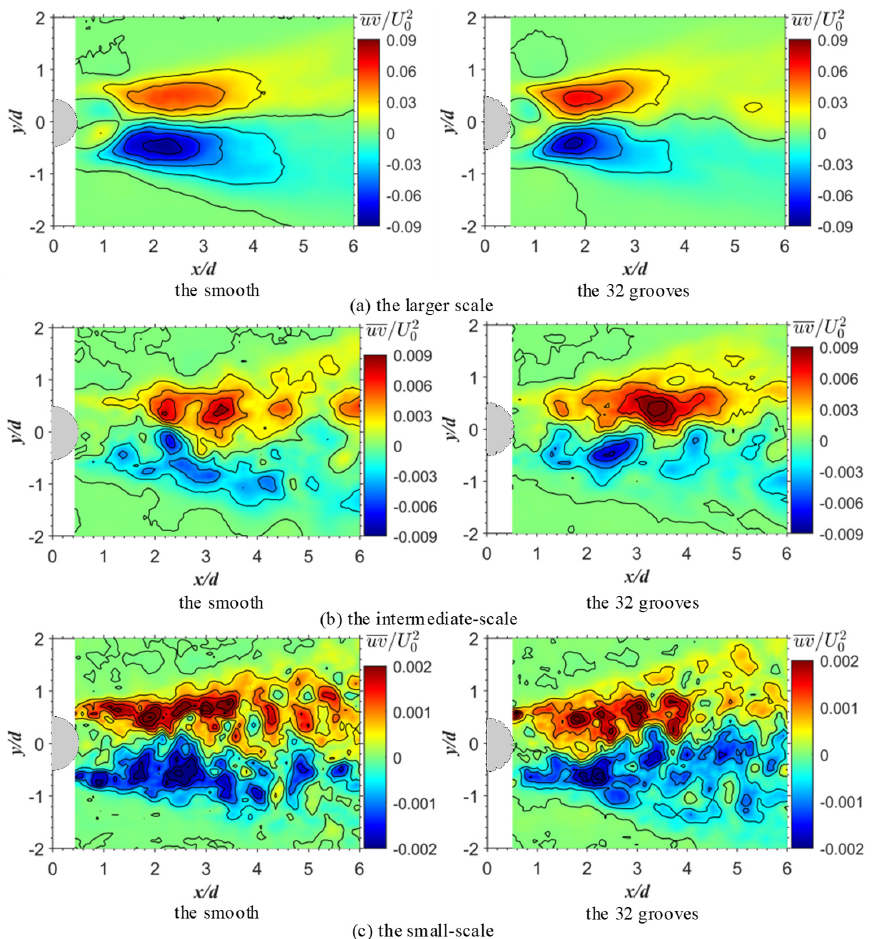
Figure 17. Multi-scale shear stress distributions of the smooth and 32-groove cylinders in the ( x, y